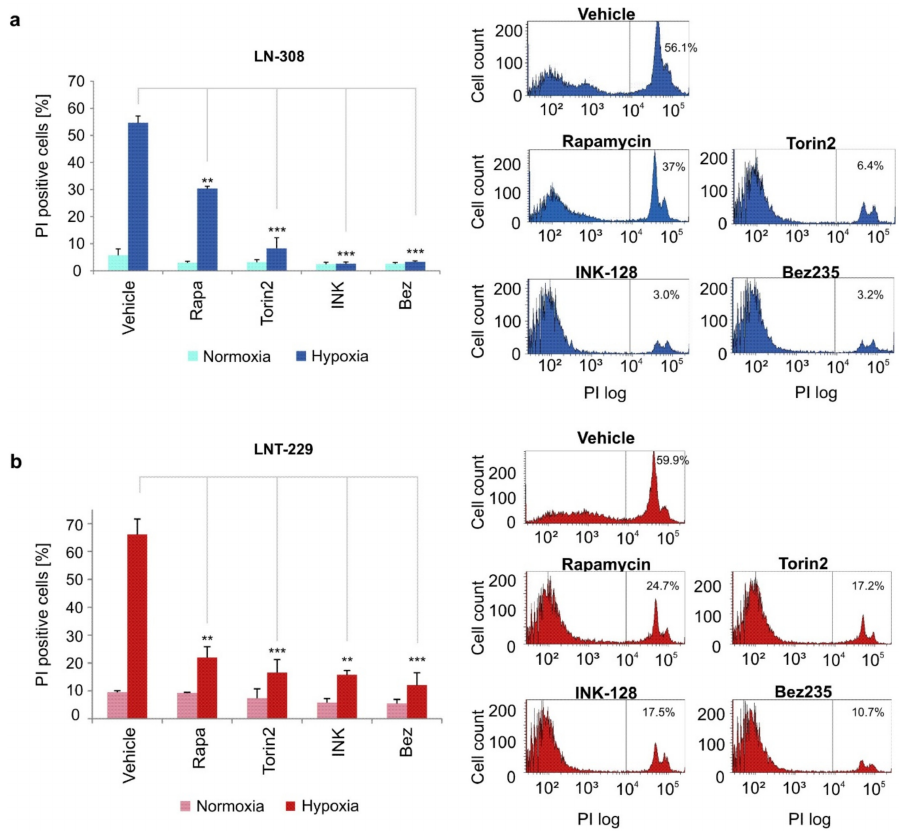
Figure 4. ATP-competitive mTOR inhibitors protect human glioma cells from hypoxia-induced cell death. LN-308 ( a ) and LNT-229 cells ( b ) were exposed to serum-free medium with 2 mM glucose and hypoxia (0.1% oxygen) and treated with rapamycin (100 nM), torin2 (100 nM), INK-128 (100 nM) or NVP-Bez235 (10 nM). Treatment duration was approximately 22 h for LN-308 and 26 h for LNT-229 cells. Cell death was then quantified by PI staining ( n = 3, mean ± S.D., ** p < 0.01, *** p <